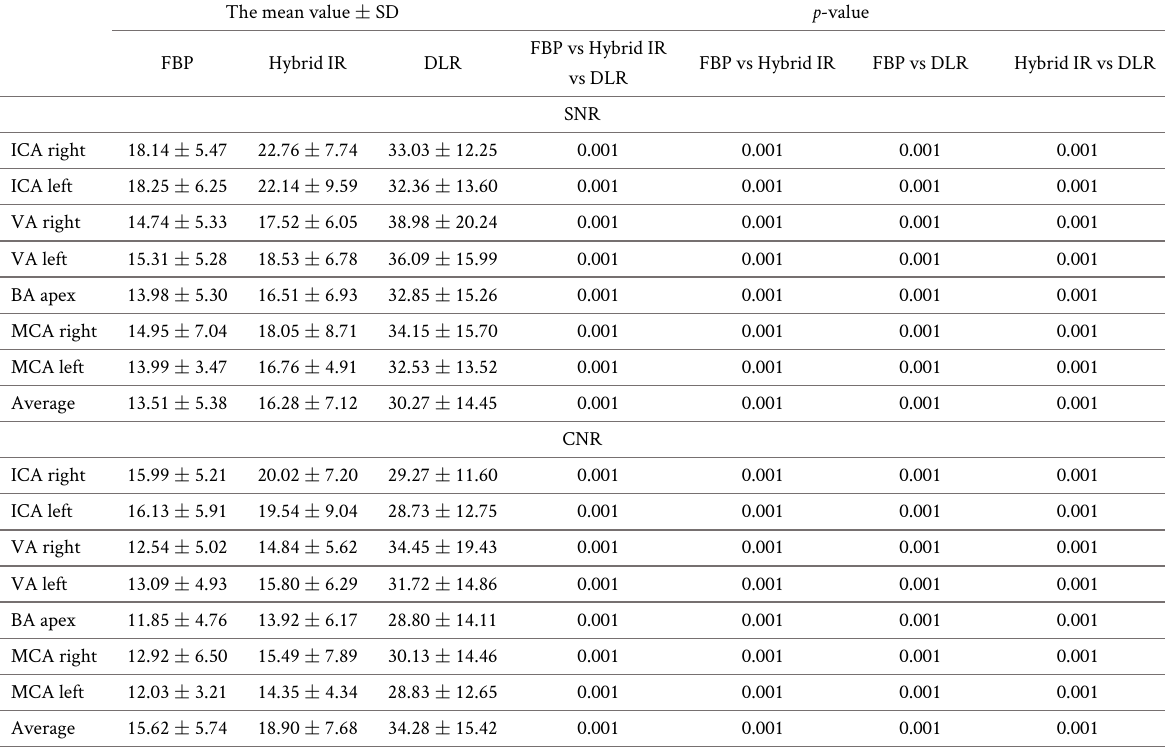
Table 2. Results of CNR and SNR.